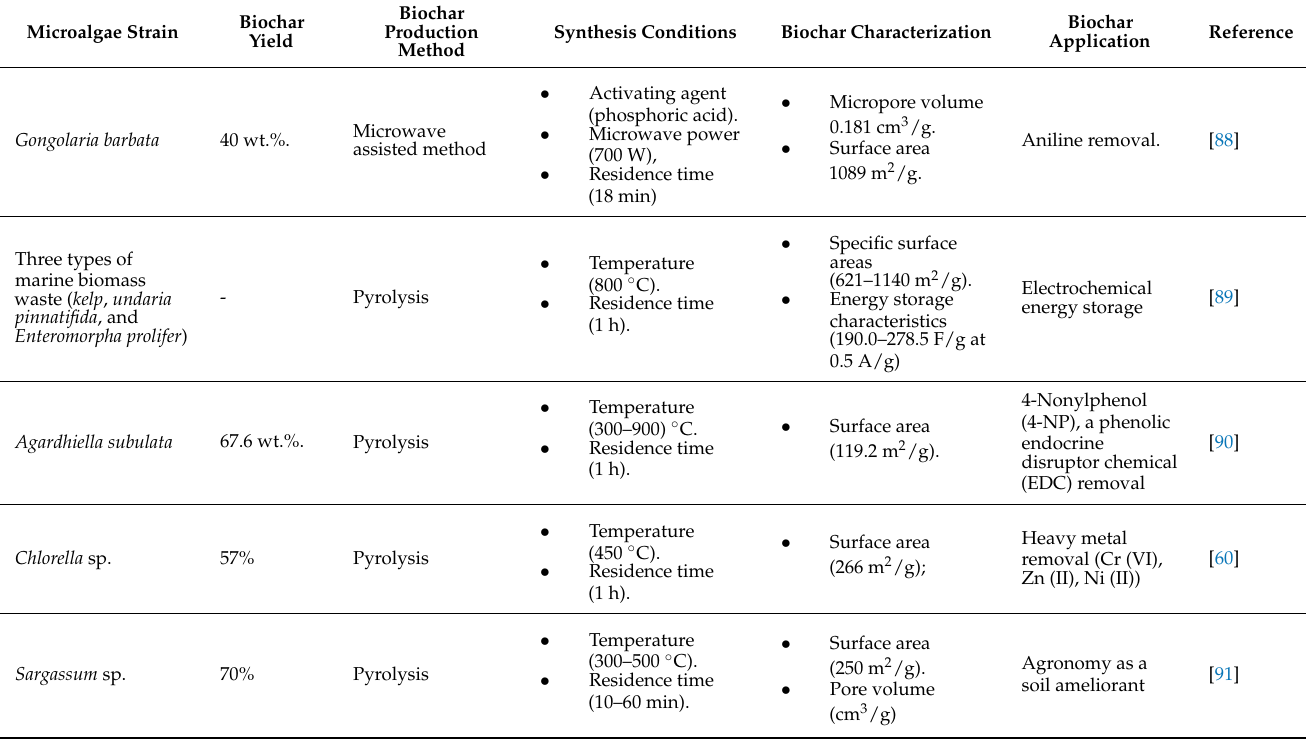
Table 1. Application of biochar derived from